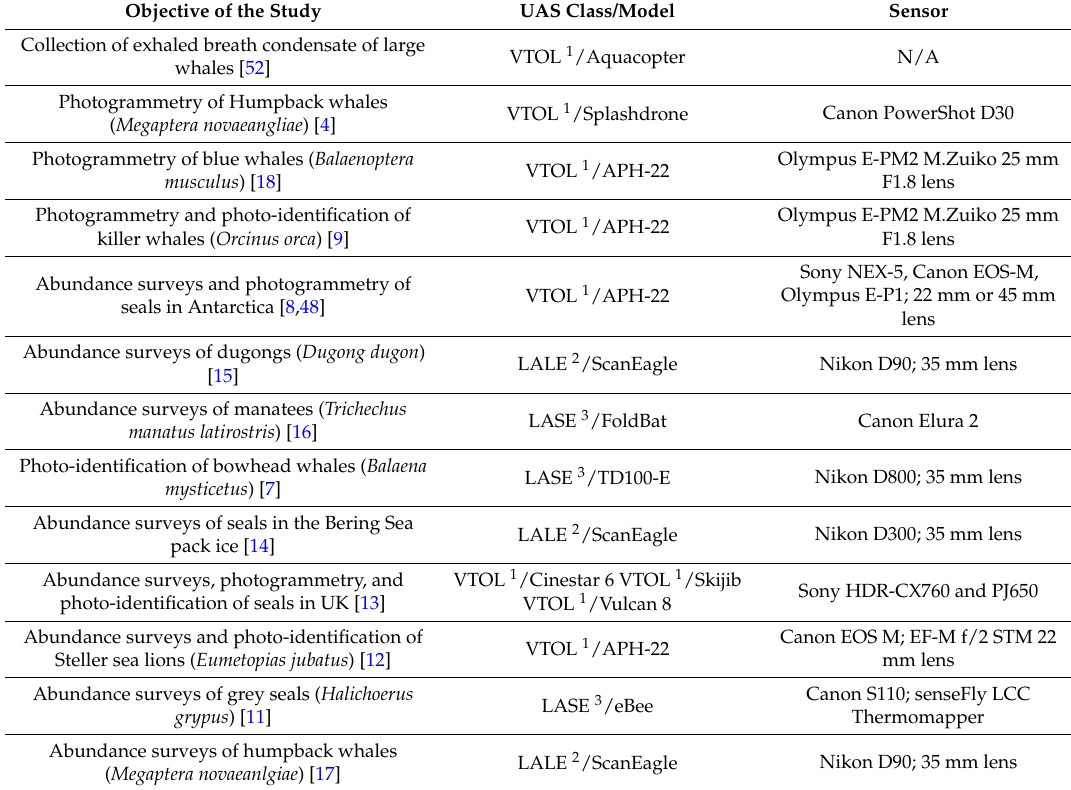
Table 1. The use of UAS in marine mammal